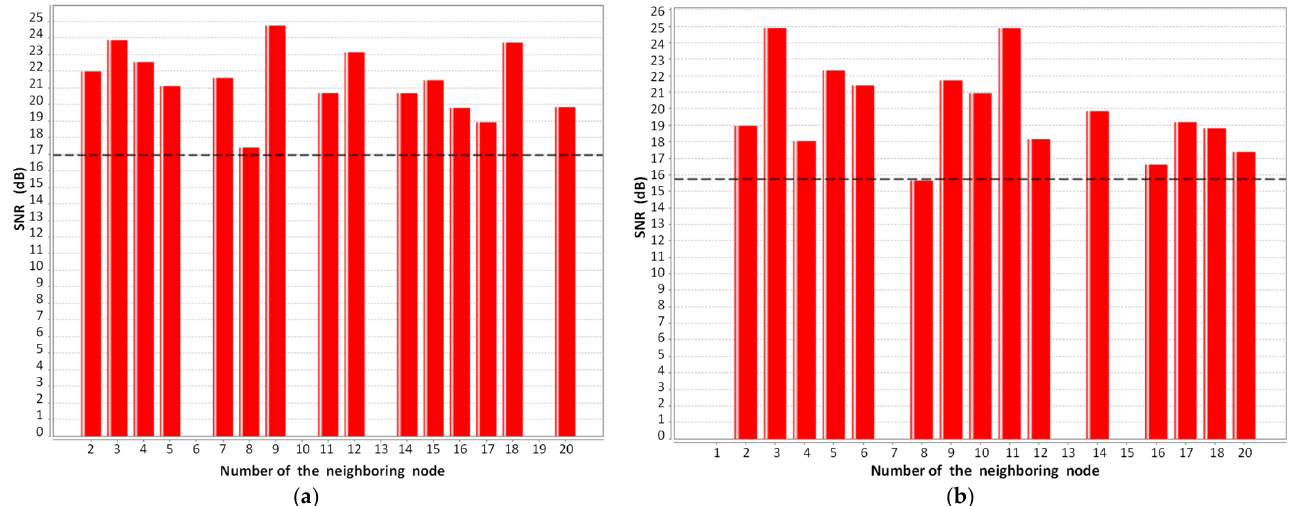
Figure 12. Estimation of the average SNR: ( a ) from node 1; ( b ) from node 19 to the other nodes of the considered network.